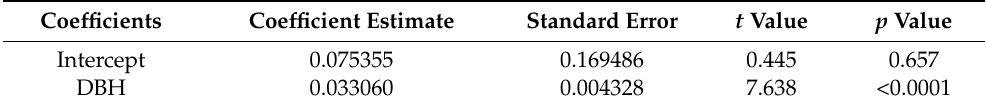
Table 1. Coefficients derived from the linear model, including the coefficient estimate, standard error, t values, and p